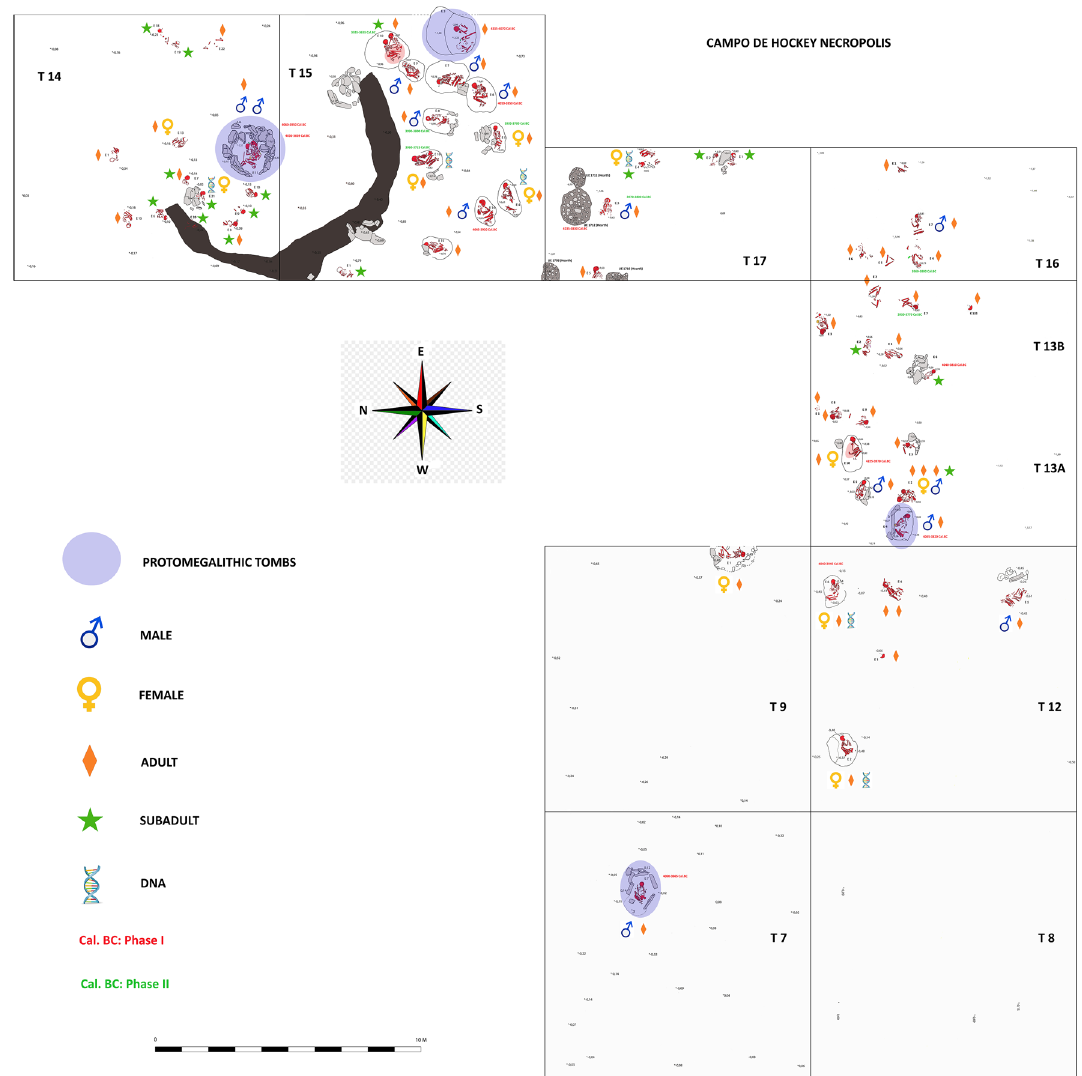
Figure 6. Plan of the Campo de Hockey necropolis, with indication of proto-megalithic tombs, sex, age, ADN- characterised individuals and radiocarbon dated tombs. Photo montage was designed with the application of Adobe Photoshop version CC 2021 (22.3.1) (http:// www. adobe.